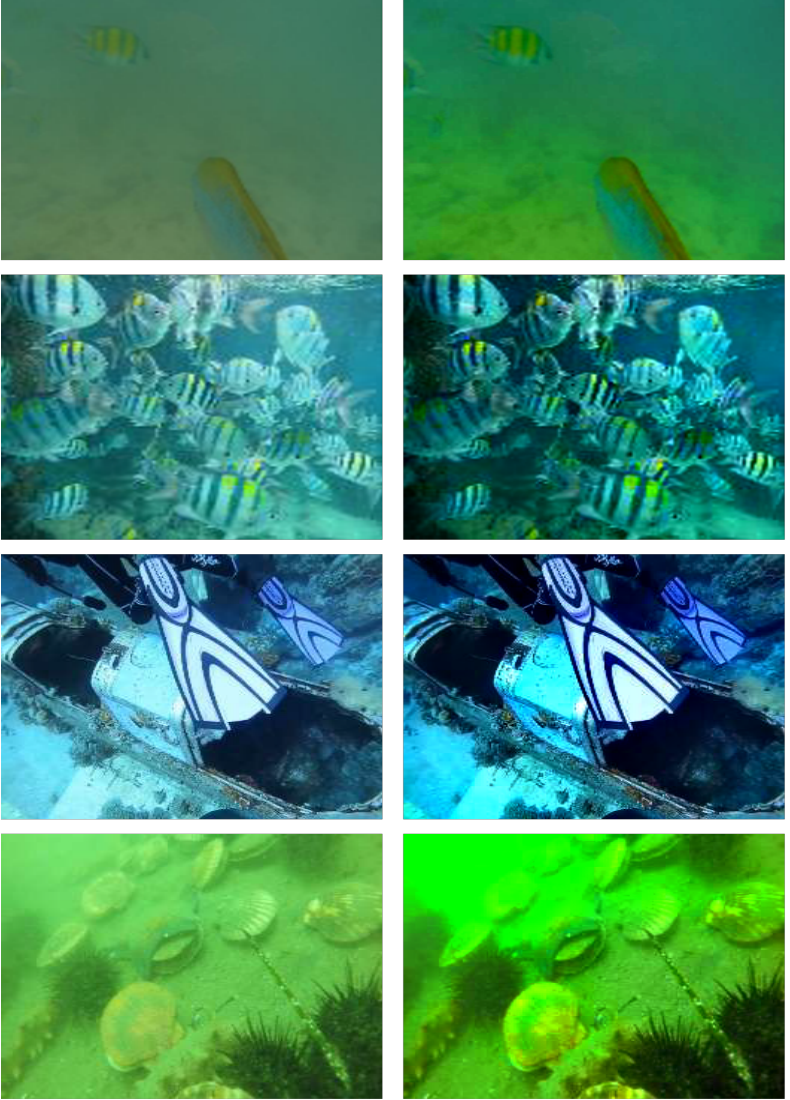
Figure 10. Subjective comparison of underwater images from [42]. From left to right are raw under- water images, results from CBF [32], ULAP [39], UWCNN [20], MLFcGAN [40], FUnIEGAN [41], waterNet [26], UICoE-Net [42] and the